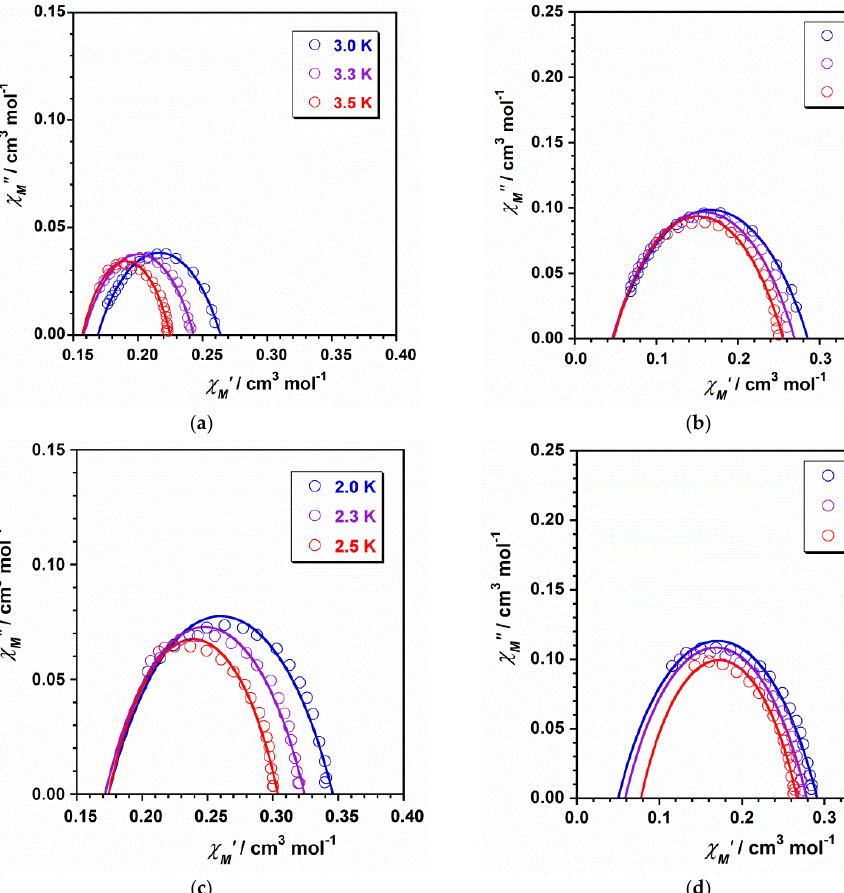
Figure 6. Cole–Cole plots for 1 ( a , b ) and 2 ( c , d ) obtained from the experimental data of the out-of-phase ac susceptibility signals under dc fields of 1000 ( a – c ) and 5000 G ( b – d